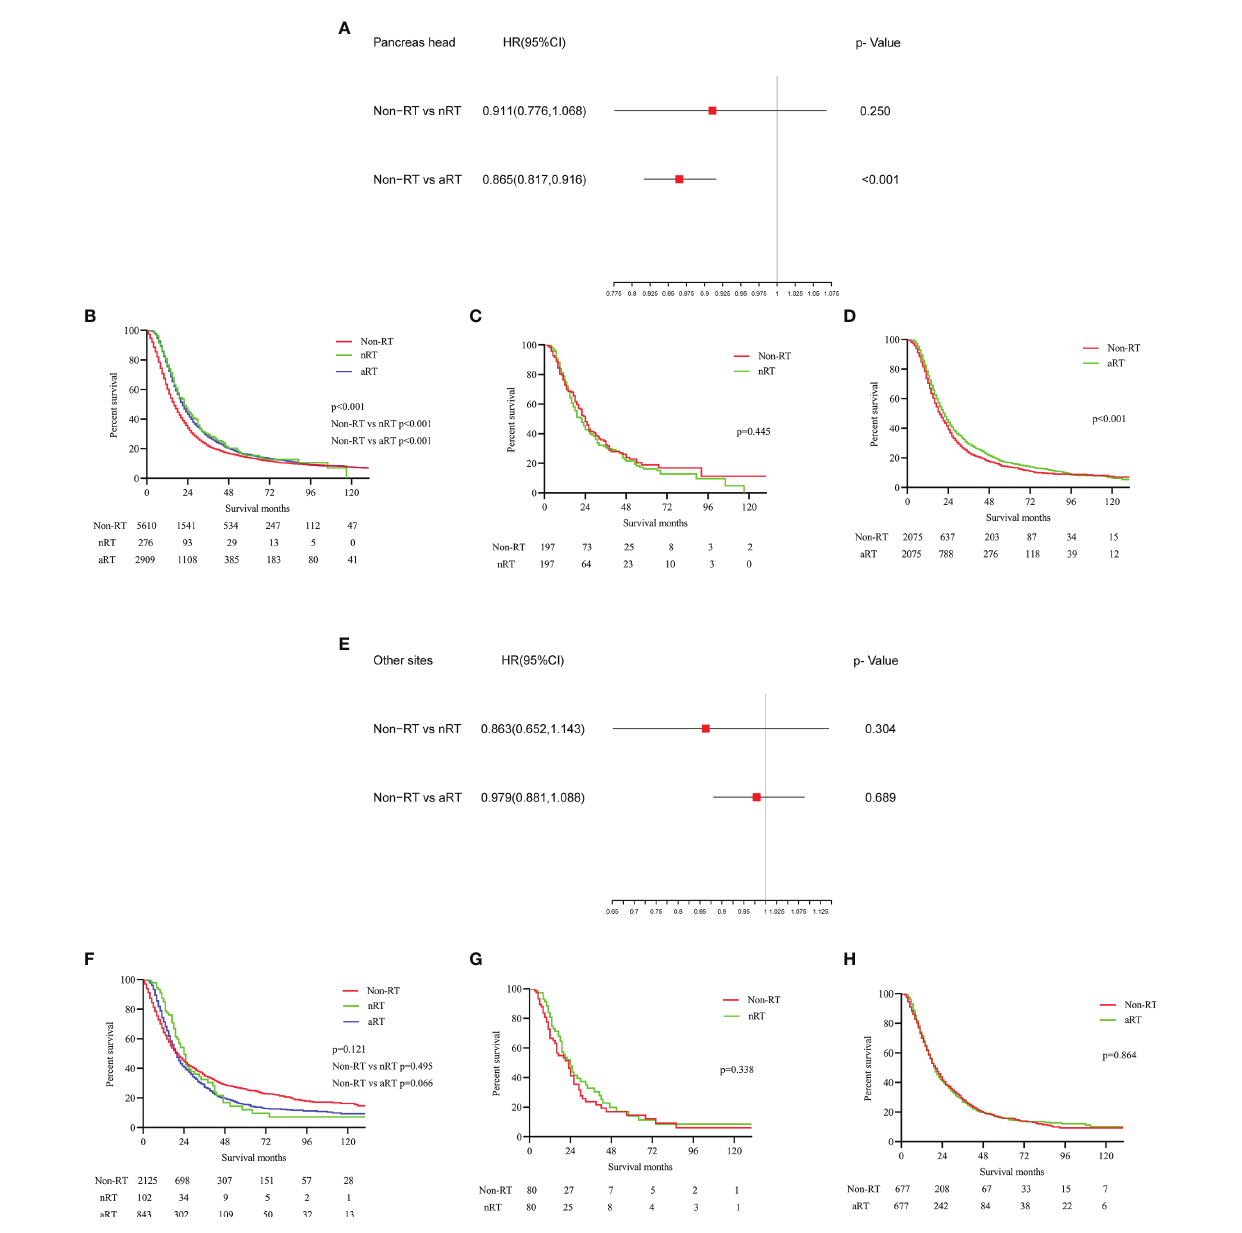
FIGURE 5 | The forest plots and the survival curves were used to demonstrate the effect of radiotherapy in stage IIB/III PDAC patients with different tumor sites. (A) The forest plot for non-RT vs. nRT and non-RT vs. aRT in patients with pancreatic head tumors; (B) The survival curve for total patients with pancreatic head tumors before PSM; (C) The survival curve for non-RT vs. nRT in patients with pancreatic head tumors after PSM; (D) The survival curve for non-RT vs. aRT in patients with pancreatic head tumors after PSM; (E) The forest plot for non-RT vs. nRT and non-RT vs. aRT in PDAC patients at other sites; (F) The survival curve for total PDAC patients at other sites before PSM; (G) The survival curve for non-RT vs. nRT in PDAC patients at other sites after PSM; (H) The survival curve for non-RT vs. aRT in PDAC patients at other sites after